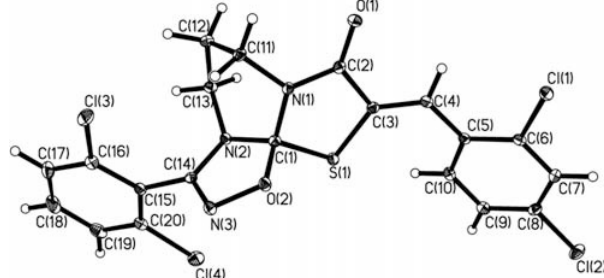
C1/N1/ C2/C3 are nearly on plane with the mean deviation from